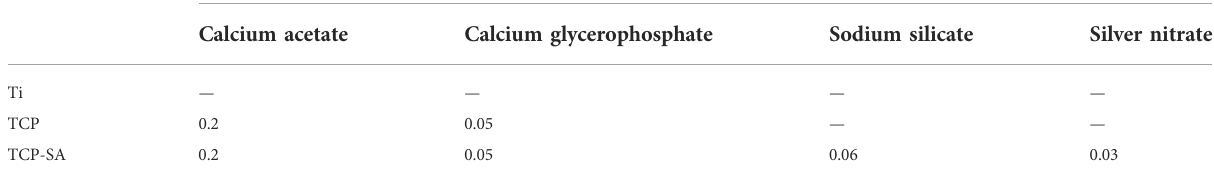
TABLE 1 Electrolyte components of different